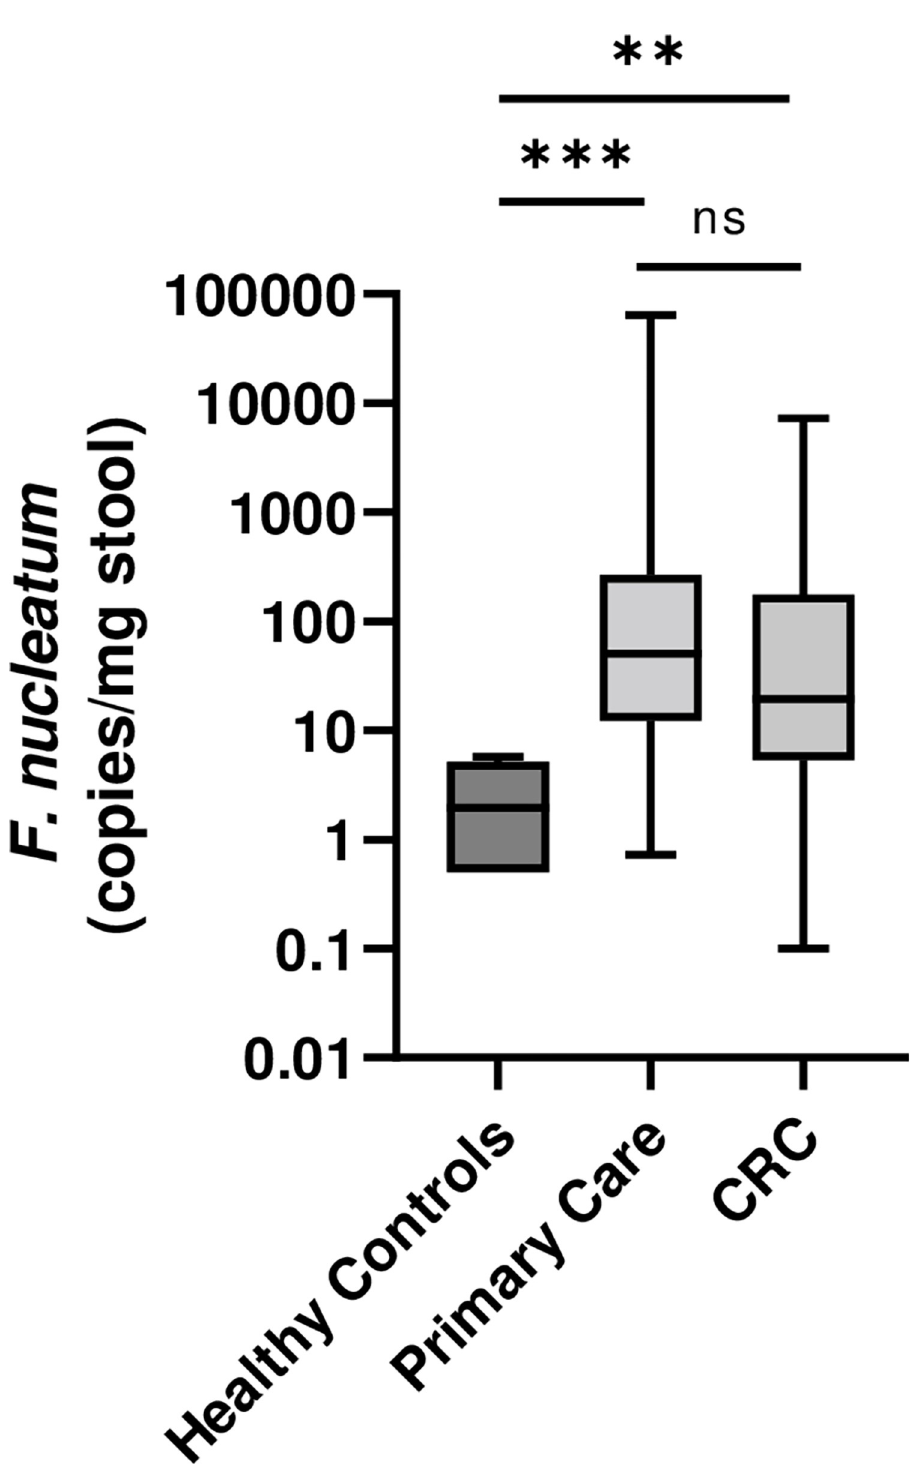
Fig 2. Abundance of F . nucleatum in stool samples. F . nucleatum abundance is significantly higher in primary care and CRC stool samples compared to healthy controls (P = 0.0008 and P = 0.0023, respectively) but is not significant between primary care and CRC cohorts, P = 0.341. Values for individual samples are shown in S1 File.